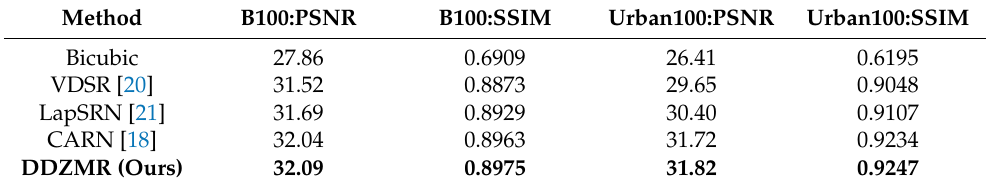
Table 2. Quantitative comparison of existing methods on the B100 [34] and Urban100 [35]